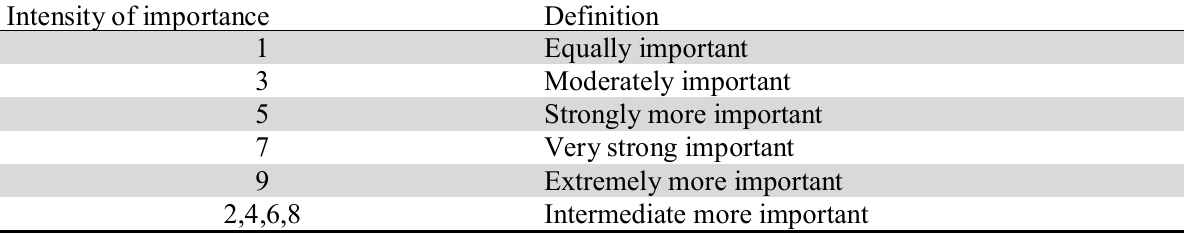
The ratio scale and definition of AHP Intensity of